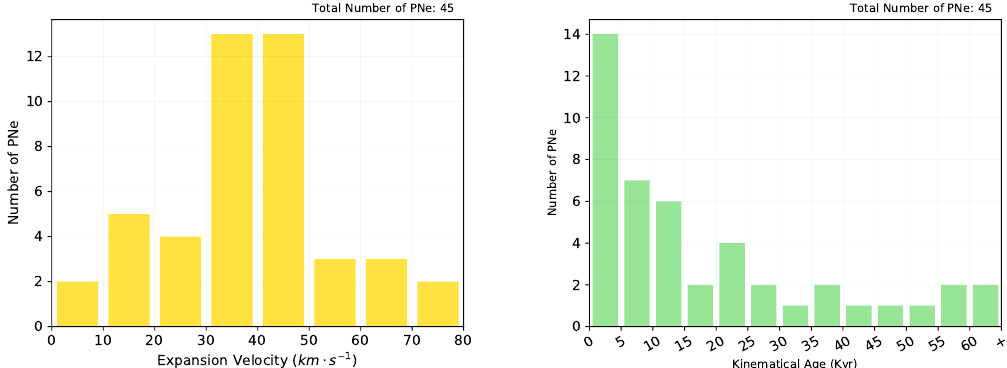
Figure 3. Expansion velocities ( left ) and kinematical ages distributions ( right